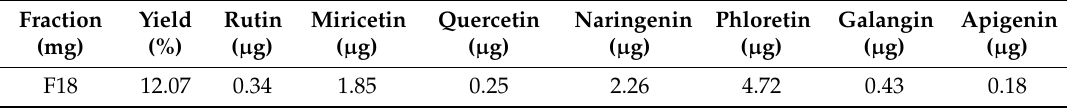
Table 2. Flavonoid yield (µg·mg − 1 ) found in F18 obtained from the methanolic extract of the fruits of